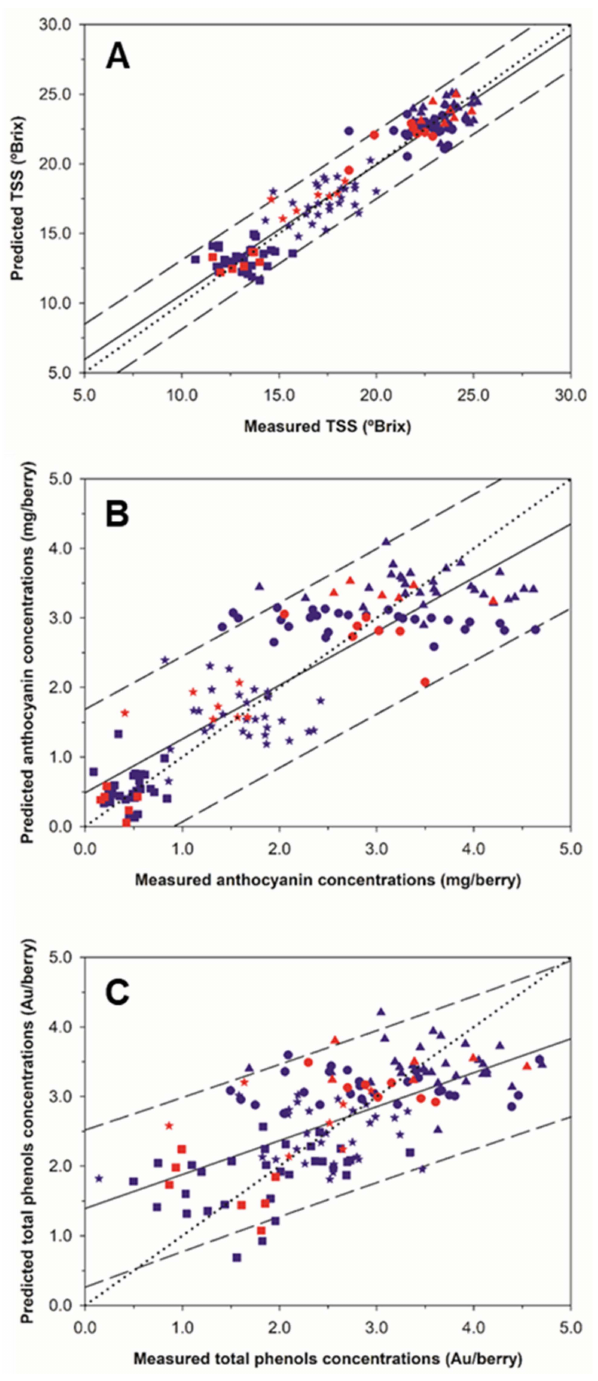
Figure 2. Regression plots for the total soluble solids ( A ), anthocyanins ( B ) and total polyphenols ( C ) using the best Partial Least Squares (PLS) models generated from on-the-go grape clusters spectral measurements. (blue color) 10-fold cross validation; (red color) external validation. ( (cid:4) : 11 August; *: 24 August; (cid:8) : 18 September; (cid:78) : 28 September). Solid line represents the regression line and dotted line refers to the 1:1 line. Prediction confidence bands are shown at a 95% level (dashed